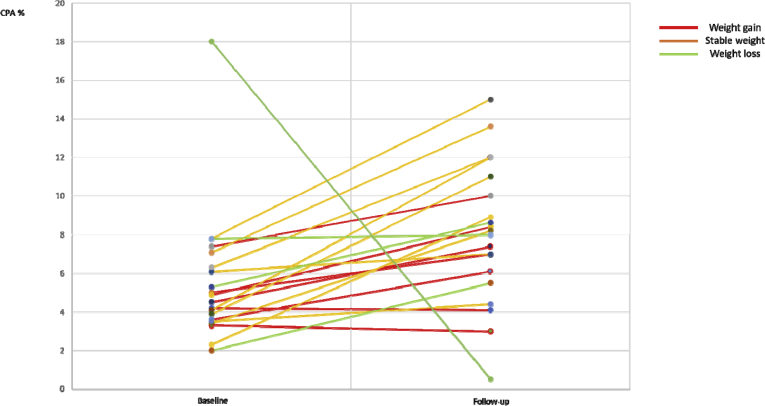
Analysis of the collagen proportionate area (CPA) in paired biopsy specimens. Differences in CPA in follow-up liver biopsy specimens compared with baseline. Patients were divided into 3 groups: those with weight gain, those with stable weight, and those with weight loss.